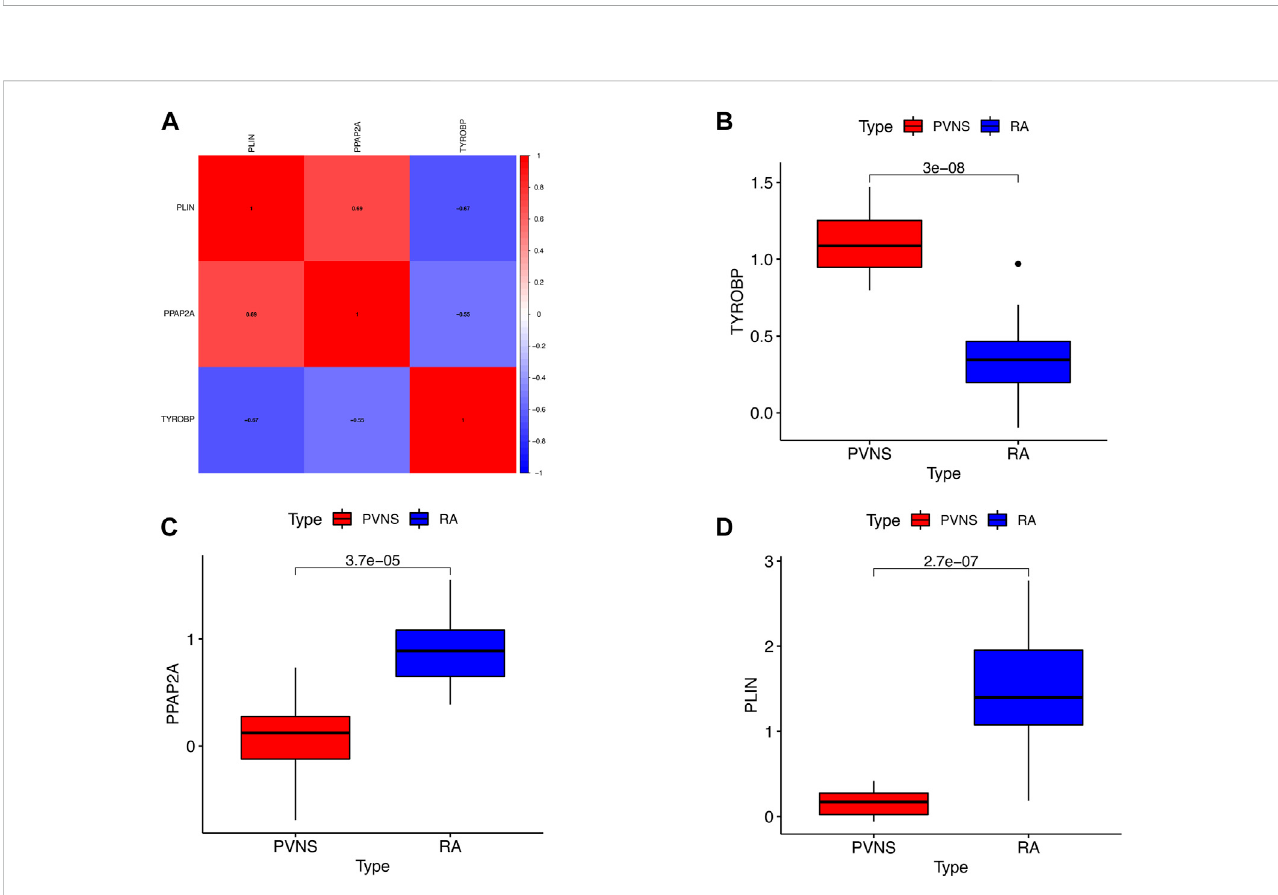
FIGURE 10 (A) Correlation of the three hub genes (B) The expression levels of upgrade hub gene in PVNS. (C,D) The expression levels of upgrade hub genes in RA.